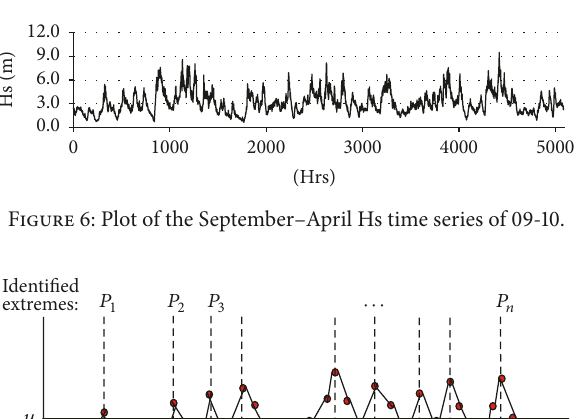
Figure 5: Plot of the September–April Hs time series of 06-07.